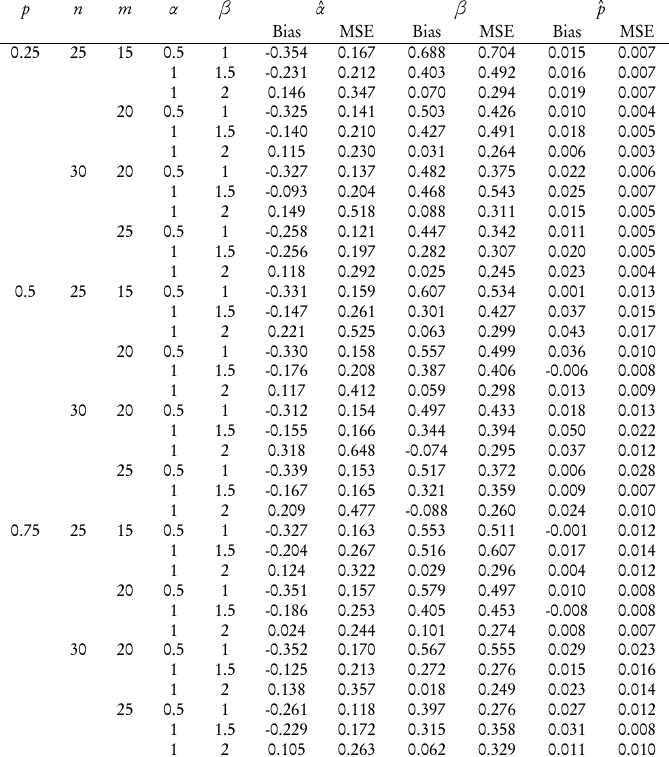
Bias and MSE of the MLE’s ˆ α , ˆ β and ˆ p for different choices n, m, α , β and p = 0.25, 0.5 and